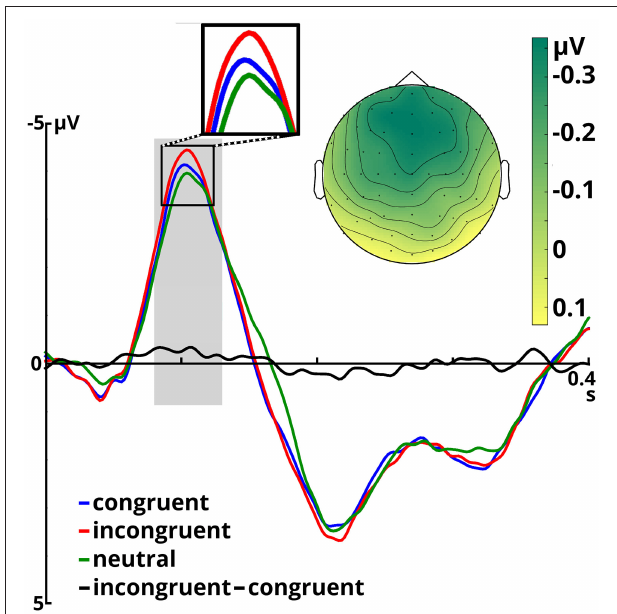
Figure 3 for results of the source reconstruction analysis.